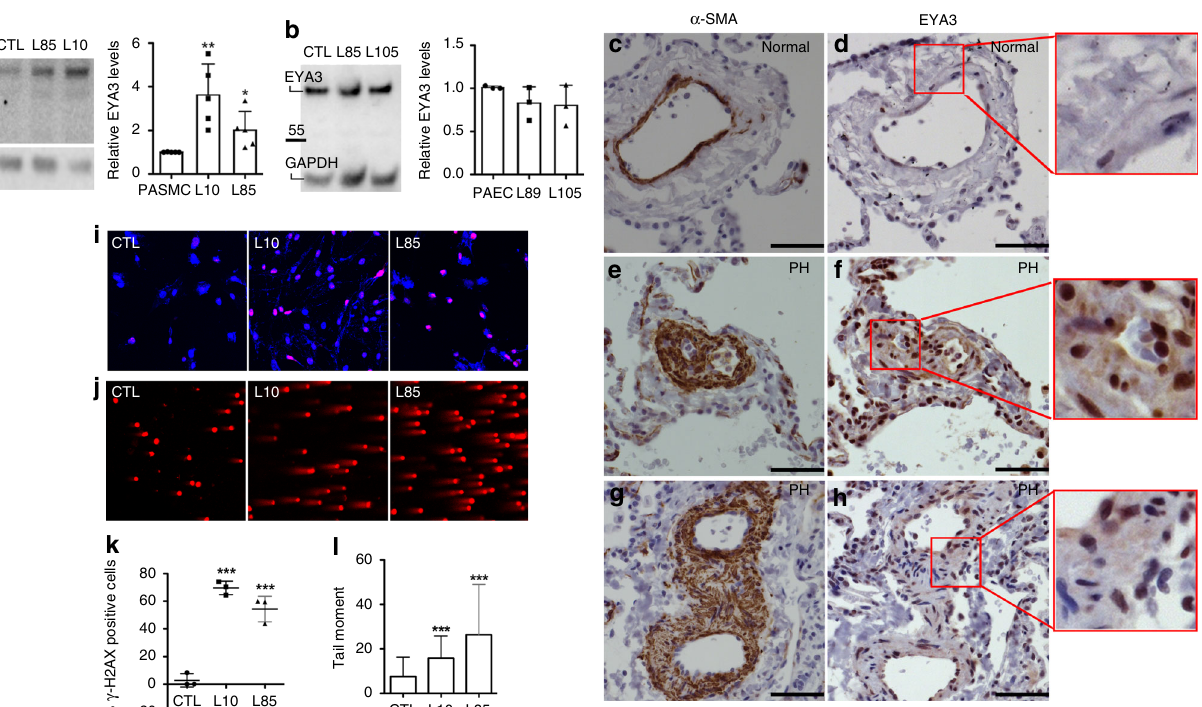
Fig. 1 PAH-PASMC have elevated levels of EYA3 and DNA damage. a , b Western blot analyses of primary human PASMC and PAEC from normal lungs (CTL) and from the lungs of PAH patients (PAH-PASMC: L10, L85, PAH-PAEC: L89, L105). Blots were probed with anti-EYA3 antibody and quantitated using ImageJ, relative levels of EYA3 in multiple experiments (PASMC n = 5, PAEC n = 3) are shown in the bar graphs (plotted as mean ± SD; statistical signi fi cance (normal versus PAH-PASMC) was determined using two-tailed t -tests, ** P < 0.01, * P < 0.05). EYA3 levels were consistently higher in PAH- PASMC compared with normal PASMC. In contrast, EYA3 levels in PAH-PAEC were not elevated relative to normal PAEC. c – h EYA3 protein levels are elevated in plexiform lesions of lungs from PH patients. Representative serial immunohistochemical sections stained with antibodies toward α -SMA ( c , e , g ) and EYA3 ( d , f , h ). Human lung tissue explants were obtained from the Cincinnati Children ’ s Hospital Medical Center Transplant Service; normal human lung tissue (transplant donor, 62-year-old female; c , d ) and two patients with PH ( e , f 14-year-old female; g , h 8-year-old female) are shown. Scale bars = 50 μ m. Higher magni fi cation of the areas enclosed by red boxes in ( d ), ( f ), ( h ) shown to the right. ( i )PAH-PASMC have higher levels of γ -H2AX than normal (CTL) subjects. Cells were stained with anti- γ − H2AX antibody (red) and DAPI (blue). j Alkaline COMET assays show increased tail moments in PAH-PASMC. k Percentage of γ -H2AX foci-positive cells is elevated in PAH-PASMC compared with normal PASMC (CTL). The number of cells containing >10 γ -H2AX foci/nucleus were counted using ImageJ. The data represent the average of independent experiments. Graph shows mean ± SD. One-way ANOVA with Dunnett ’ s post-test was conducted. *** P < 0.001. l Tail moments in PAH-PASMC compared with normal PASMC (CTL). Tail moments calculated using OPENCOMET on > 100 cells per sample and two independent experiments. Graph shows the median with range. One-way ANOVA with Dunnett ’ s post-test was conducted. *** P < 0.001. Source Data are provided as a Source Data fi